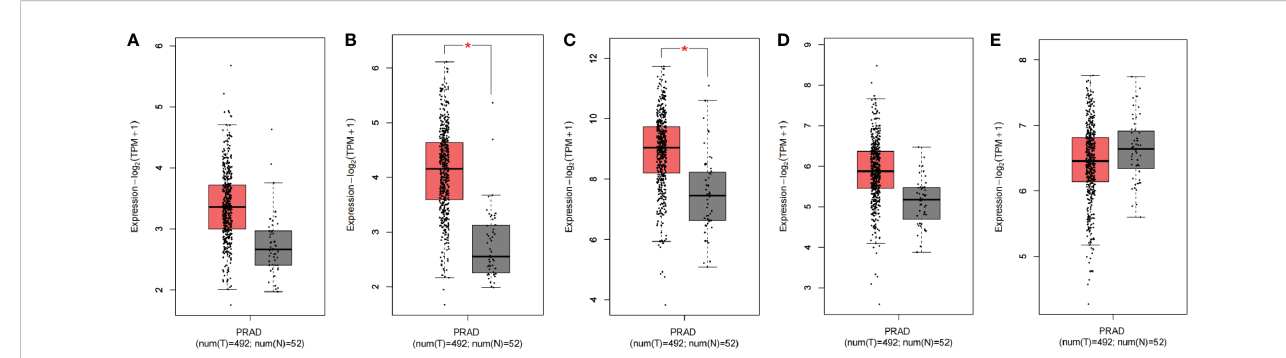
FIGURE 5 Expression levels of fi ve lncRNA in prostate cancer tissues and normal tissues. (A) PCAT6; (B) SNHG3; (C) NEAT1; (D) SNHG7; (E) NORAD. “ ∗ ” means | Log2Fold Change(FC)|>1 and p <0.01. The red box plots represent genes expressed in cancer tissues, and the grey box plots represent genes expressed in normal tissues.